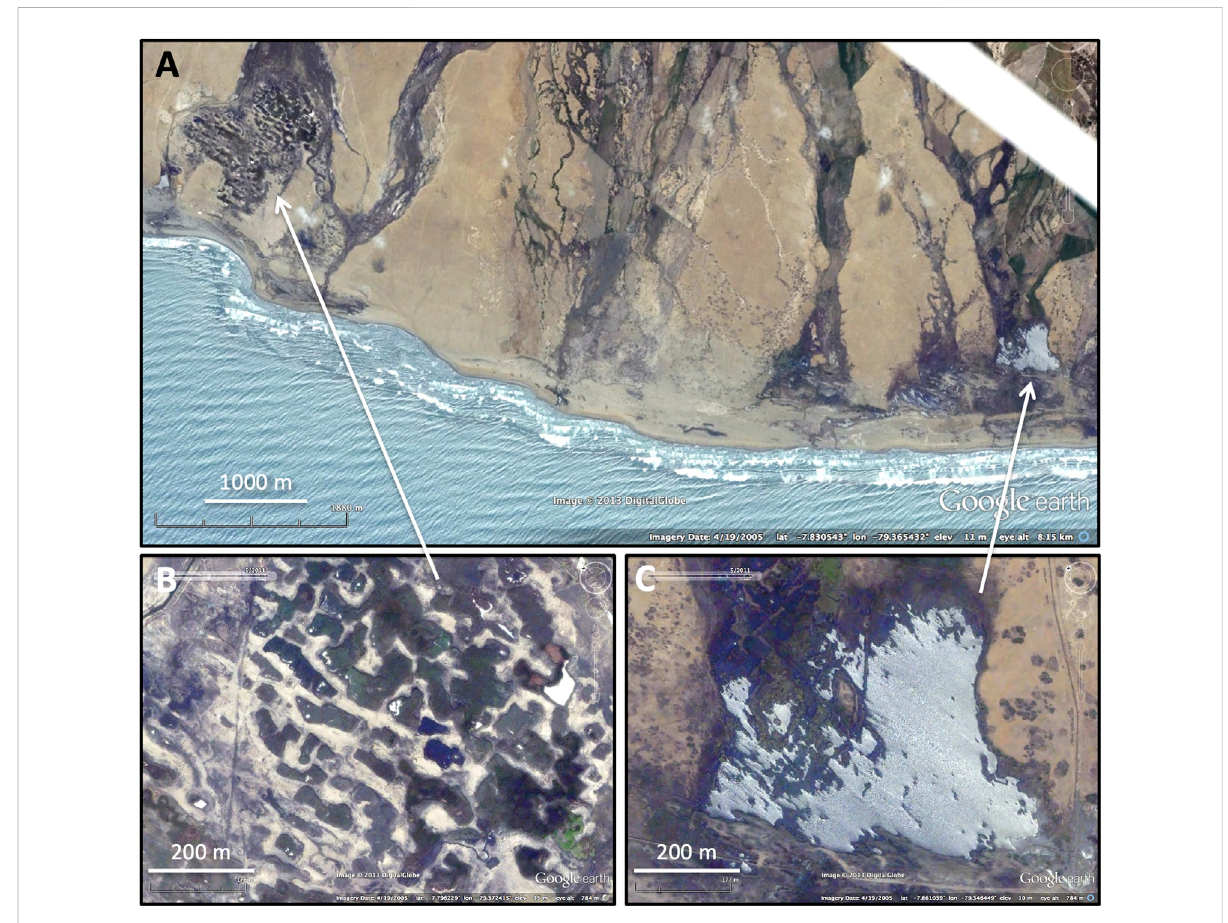
Google Earth ® images of the alluvial plain north of the Chicama River valley. (A) The alluvial plain comprises gravelly, barren inter fl uves alternating with the outwash channels that de fi ne shallow depressions close to the water table and vegetated with wetland plants and desert scrub. (B) Close-up image of the vegetated area on the left (north) side of (A) , showing the area that comprises a cultural landscape organized into terraces and camellones (raised fi elds) for agricultural production, which were initially constructed ~5,000 BP. (C) Close-up image of the area on the right(south)sideof (A) showingasmallopen-waterlagoonandwetlandfringethatlocallyformwherechannelscourhasbeenespeciallydeepduring El Niño fl